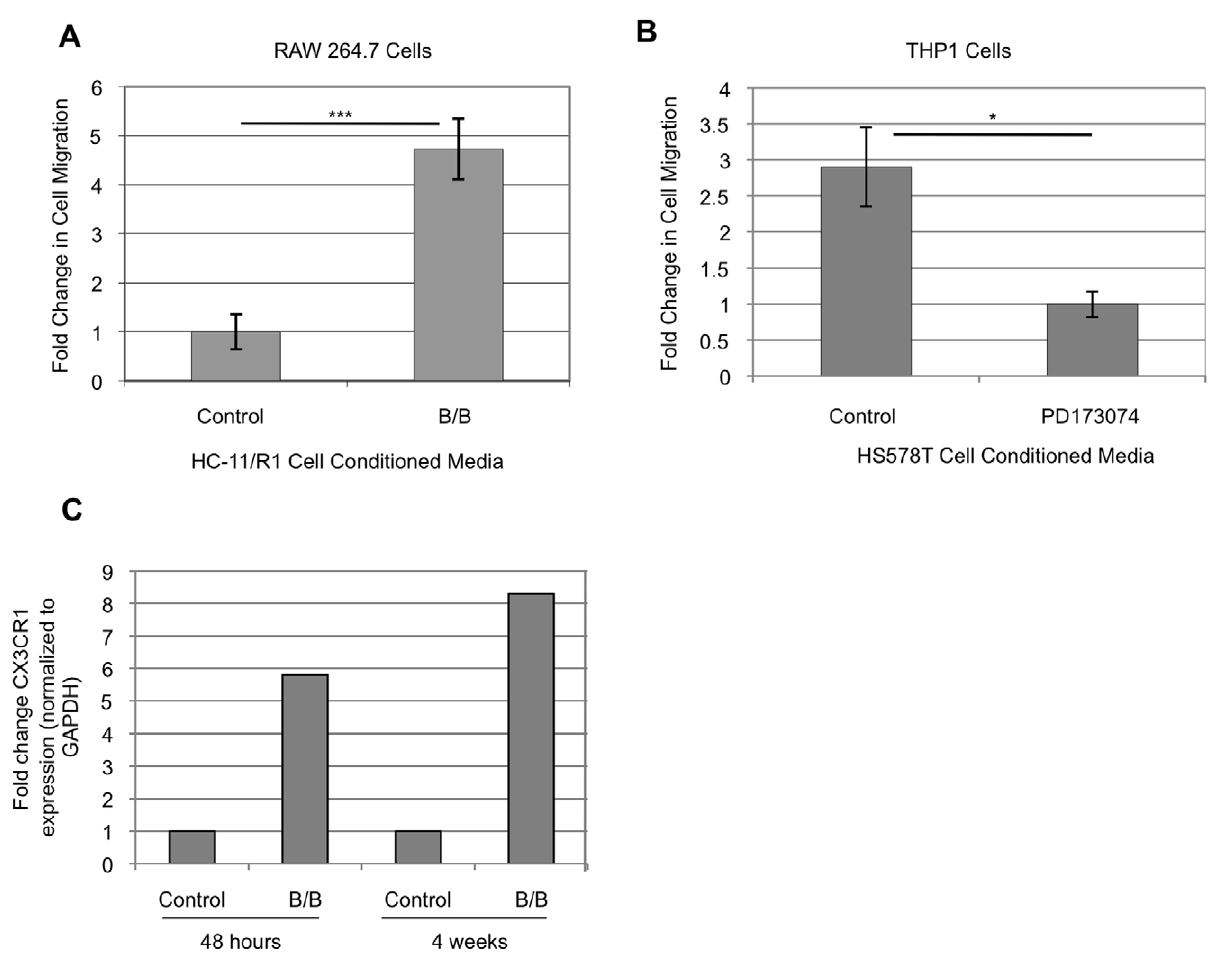
Figure 1. FGFR activation in mammary epithelial cells and breast cancer cells promotes macrophage recruitment. A) Conditioned media from HC-11/R1 cells containing soluble factors induced following treatment of cells with either B/B to activate iFGFR1 or ethanol as a solvent control for 24 were used to assess migration of RAW 264.7 cells. A significant induction in macrophage recruitment was observed in response to media containing iFGFR1-induced soluble factors. ***p , 0.001. B) Conditioned media from HS578T cells treated with either PD173074, which inhibits FGFR activity, or DMSO as a solvent control were used to assess recruitment of THP-1 cells. A significant decrease in macrophage recruitment was observed in response to media from cells treated with an FGFR1 inhibitor. *p , 0.05. Error bars represent SEM. C) Expression of CX3CR1 in macrophages isolated from mammary glands of mice treated with either B/B or solvent control for either 48 hours or 4 weeks. Expression levels were assessed using microarray analysis and expression levels are normalized to levels of GAPDH.